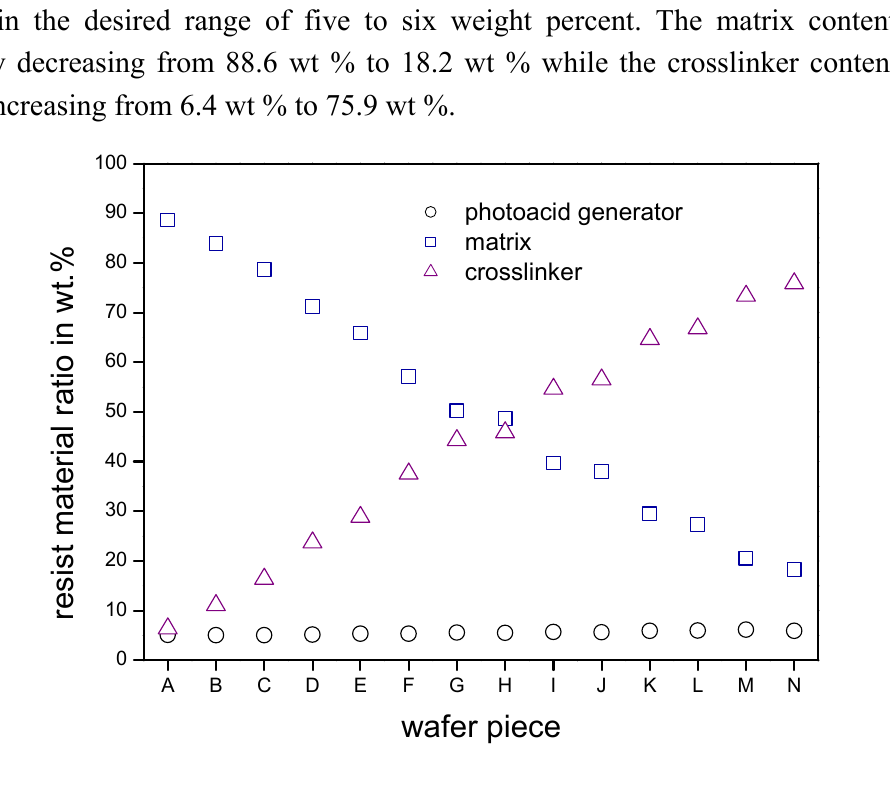
Table 1. Material composition ratios of each wafer piece of the three components resist gradient film analyzed by high performance liquid